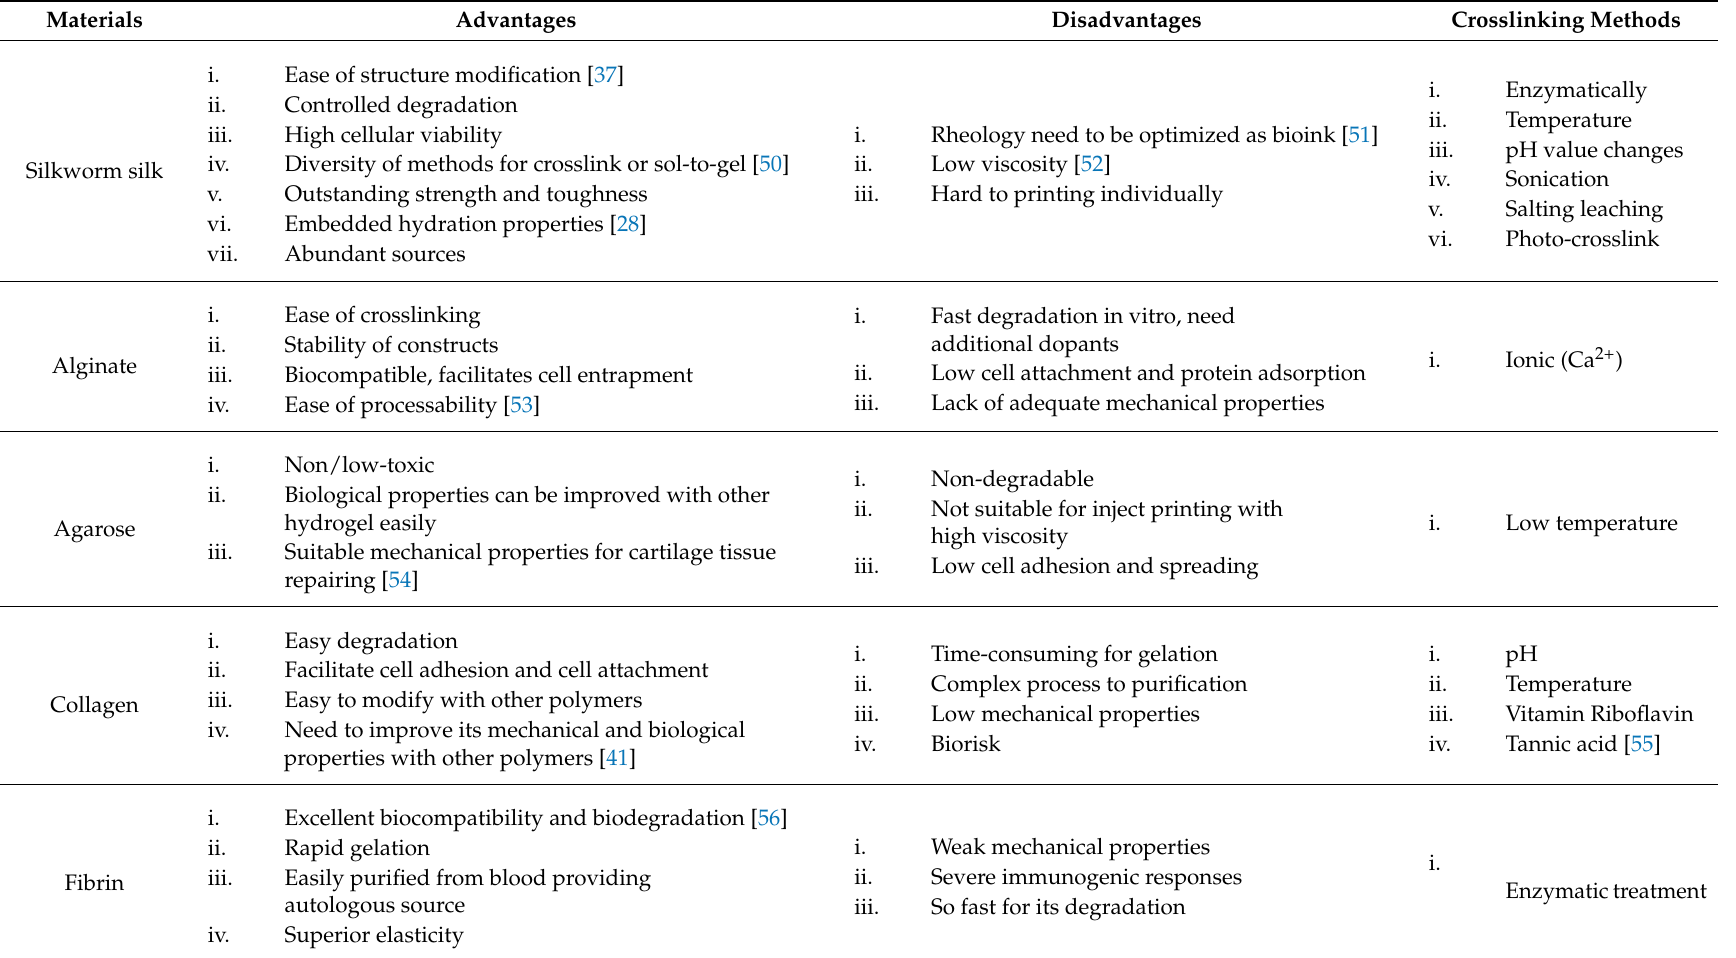
Table 1. Comparative analysis of silk versus other pure polymeric